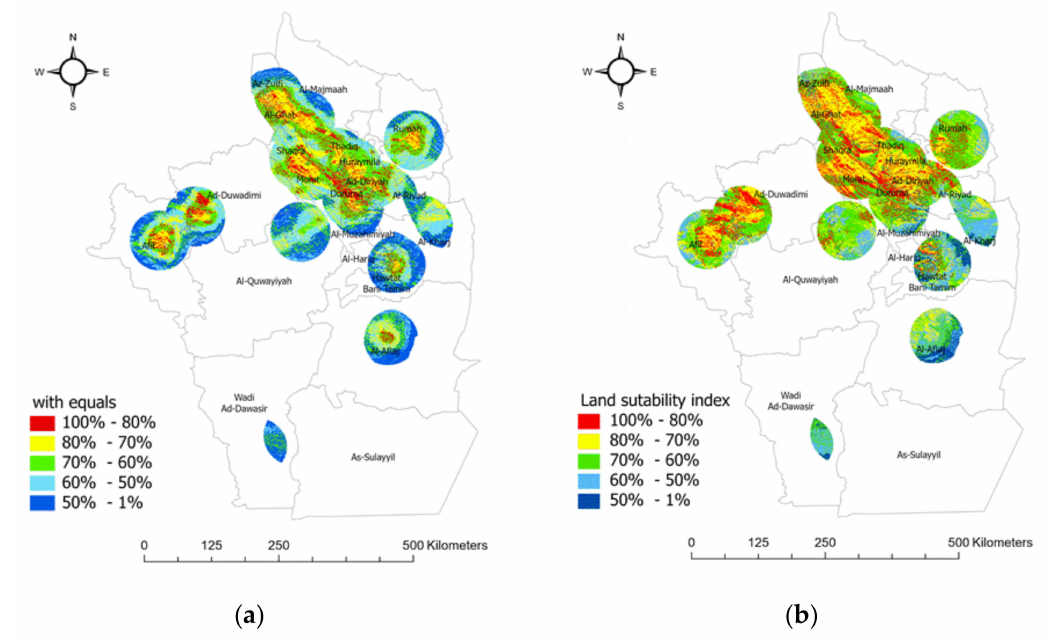
Figure 13. Sensitivity analysis with equal weights ( a ); original ( b ).